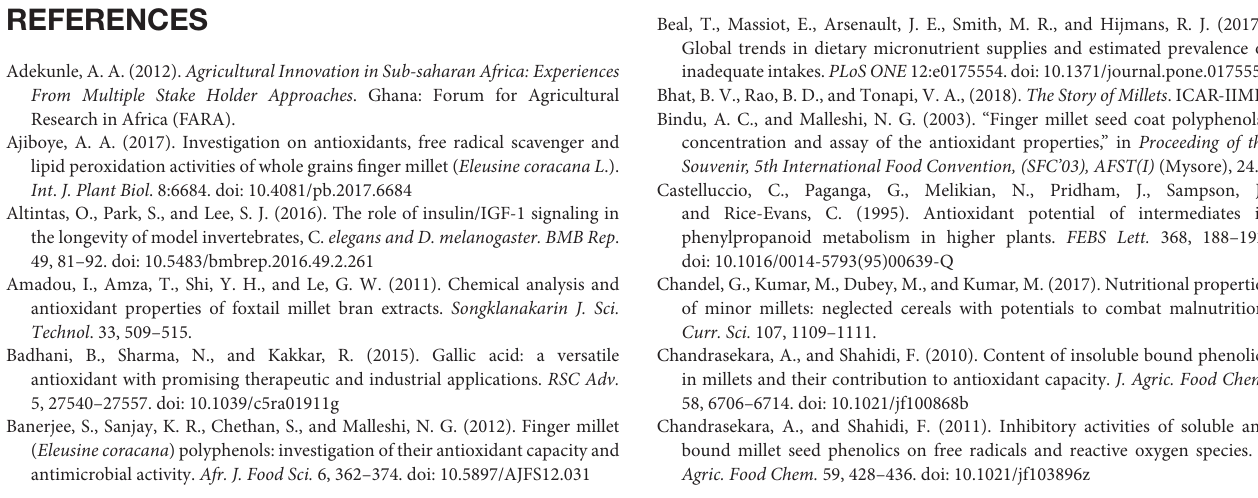
Supplementary Figure S1 | Structure of major phenolic compounds present in millets. Supplementary Figure S2 | Basic structure of flavonoids reported in